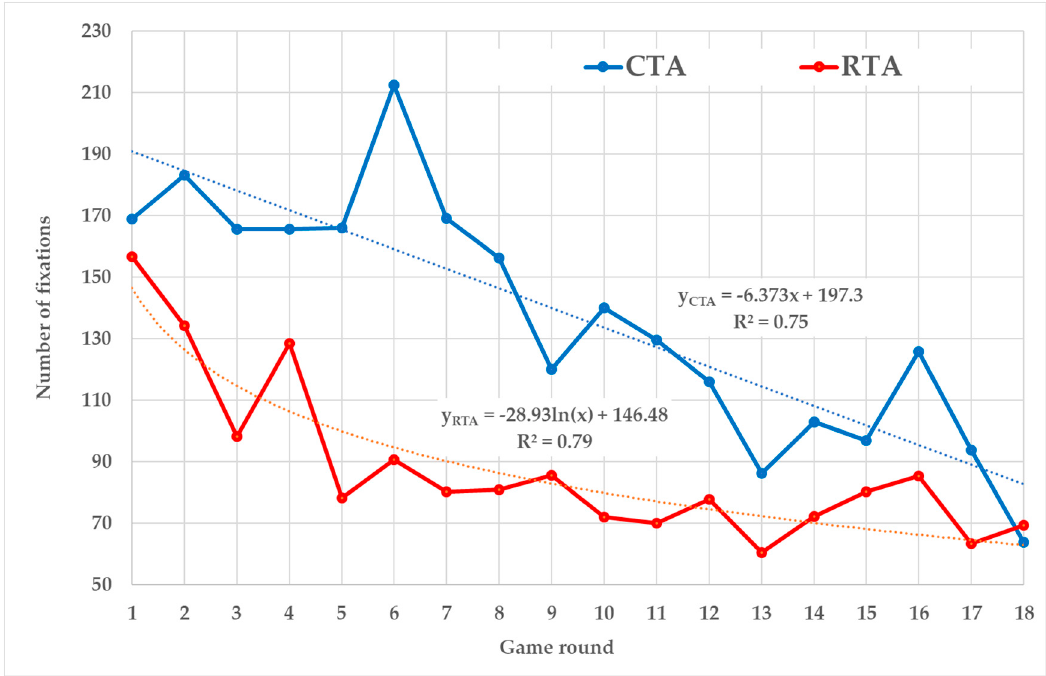
Figure 2. Number of fixations.